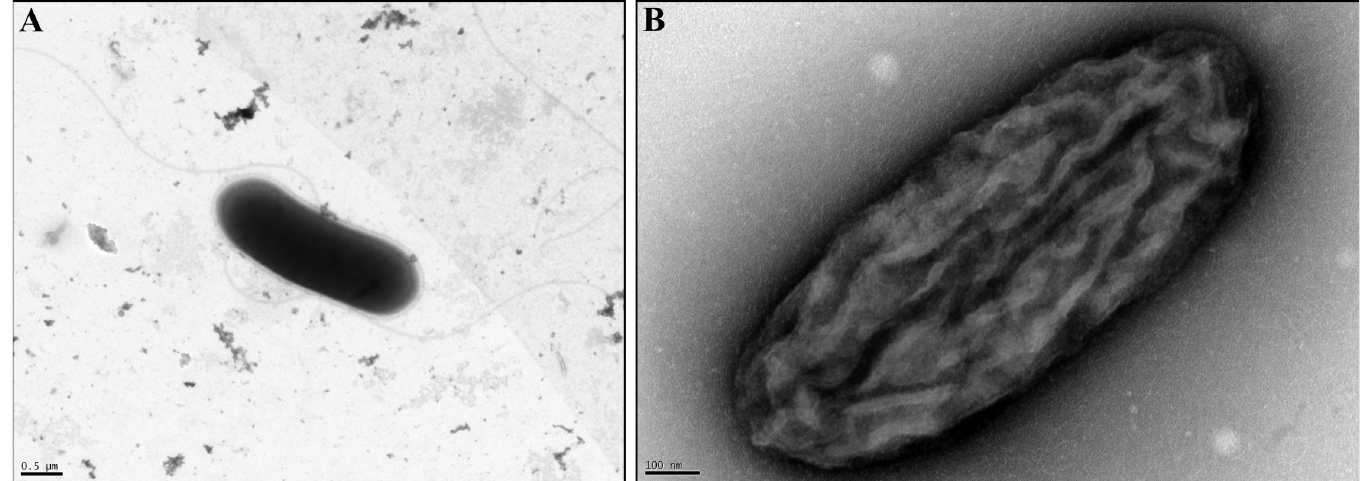
Fig 1. Transmission electron micrograph of Pontibacillus sp. ALD_SL1 (A) and Psychroflexus sp. ALD_RP9 (B). Cells from an overnight culture were stained with phosphotungstic acid (A) or uranyl acetate (B). A: rod-shaped Pontibacillus sp. ALD_SL1 with two long peritrichious flagella. B: Psychroflexus sp. ALD_RP9 cells are rod- shaped and lack flagella or pili. EPS are visible as a web of thin filaments broadly surrounding the cell. The scale bars in the bottom left measure 0.5 μ m (A) and 0.1 μ m (B).